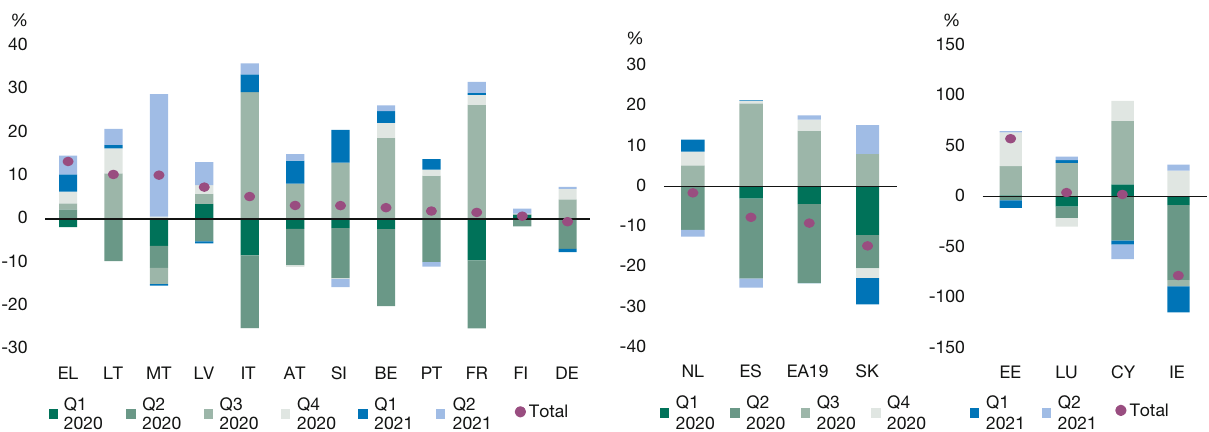
Changes in gross fi xed capital formation since the onset of COVID-19